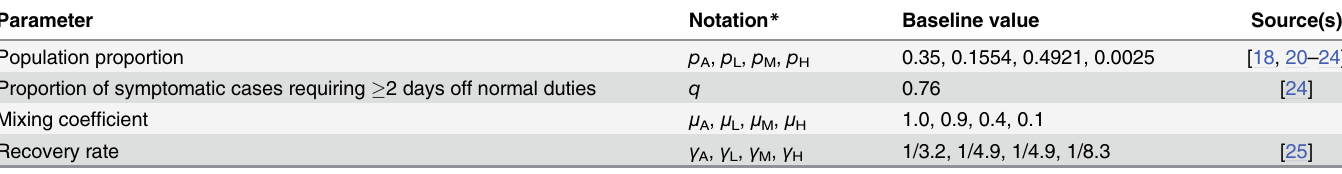
Table 1. List of model parameters and their